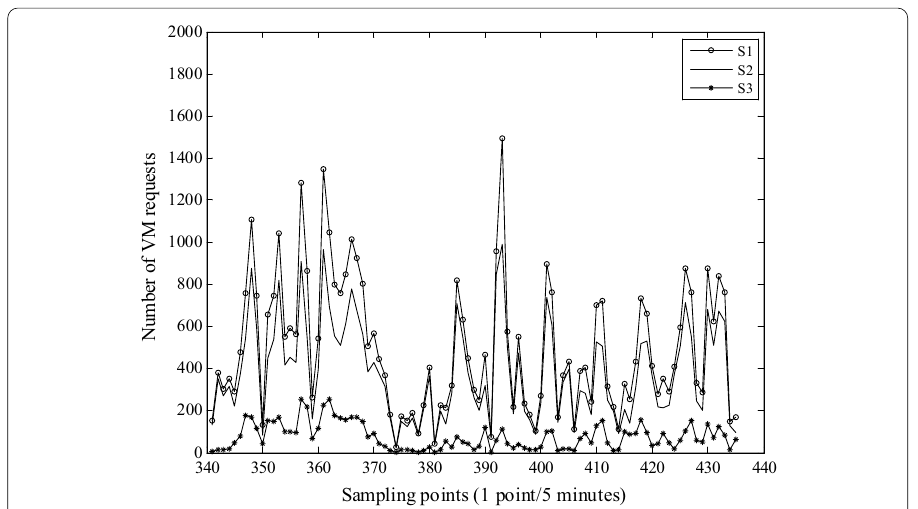
Fig. 6 The preprocessed sequences of VM requests. The S1, S2 and S3 curves represent the preprocessed sequences after using a cubic spline interpolation method to replace the outliers of the original S1, S2 and S3 sequences, respectively